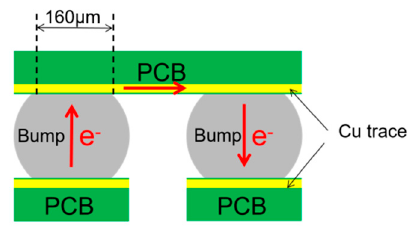
Figure 1. The schematic diagram of the electromigration test for Sn3.5Ag0.5Cu solder joints.